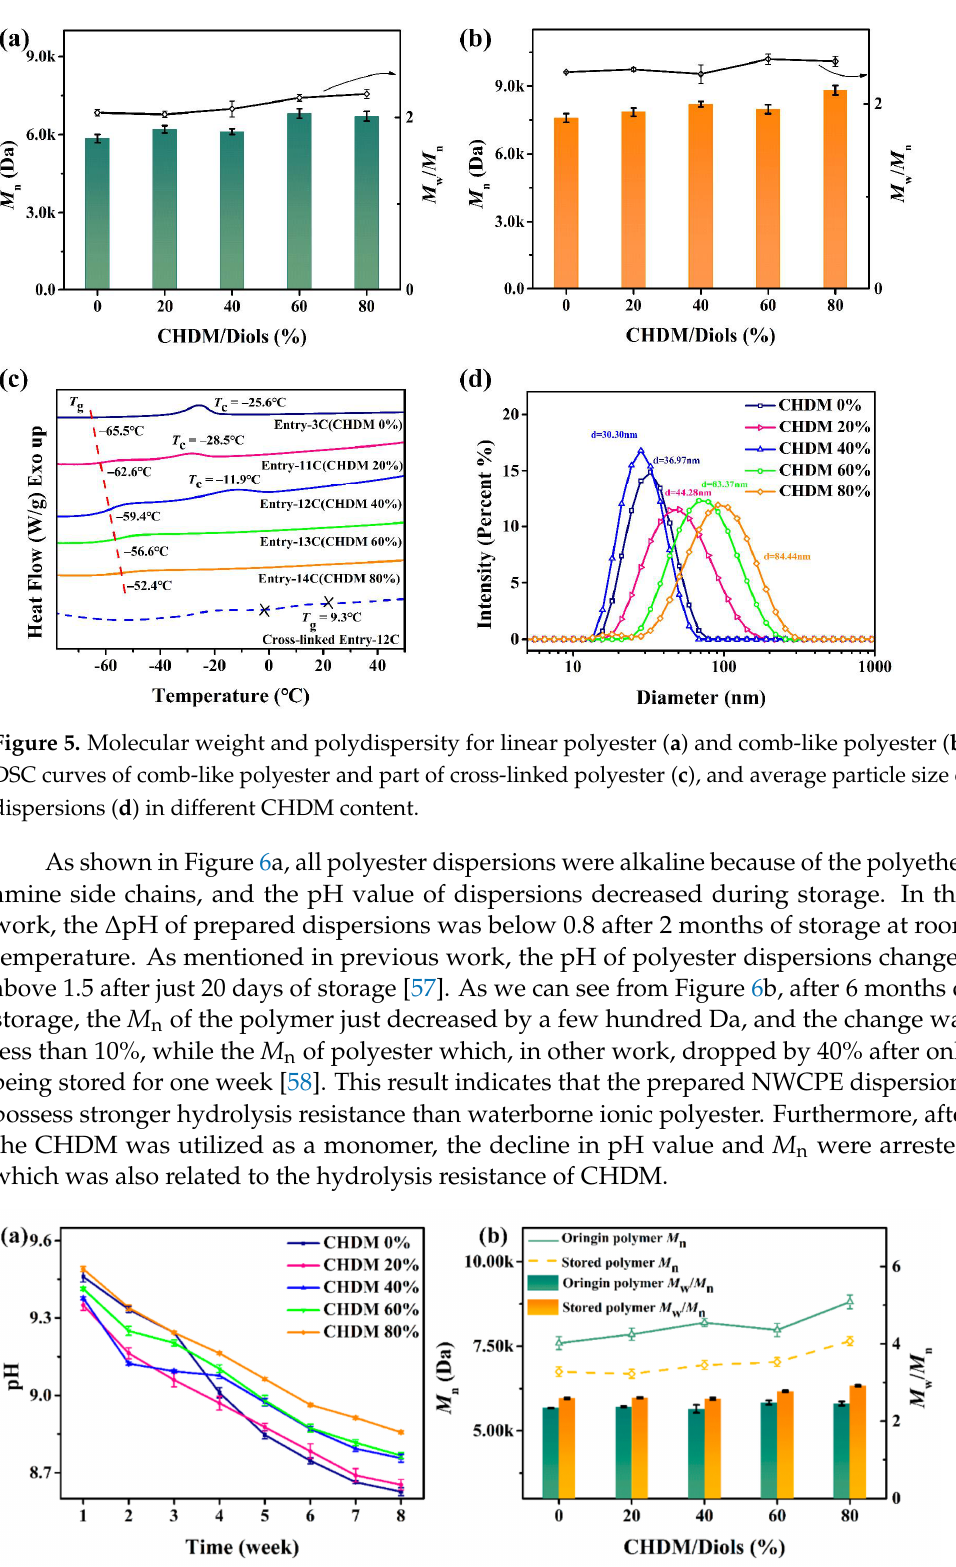
Figure 6. The ∆ pH of dispersions ( a ), and ∆ M n of comb-like polyester after storage for 6 months ( b ) in different CHDM